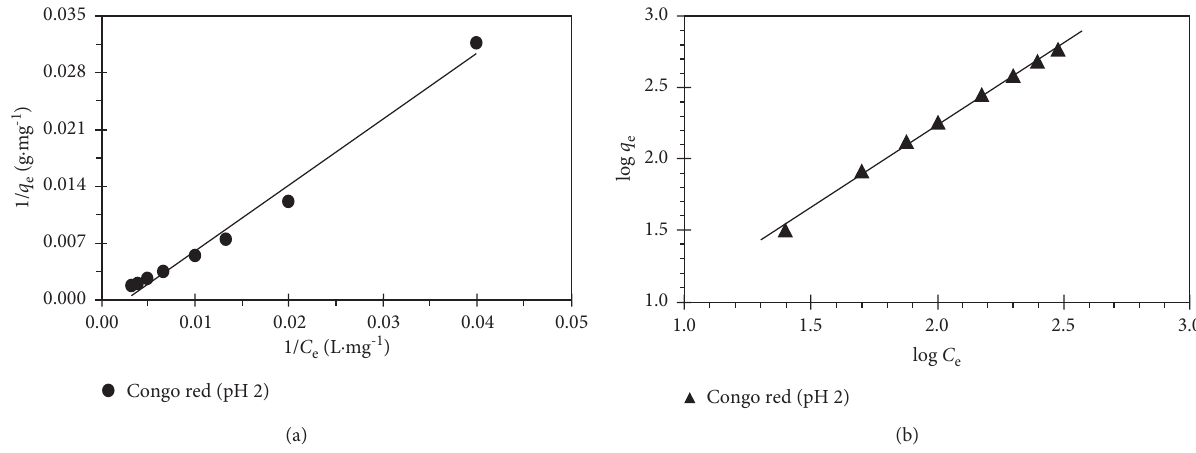
Figure 8: Isotherm analysis using (a) Langmuir and (b) Freundlich